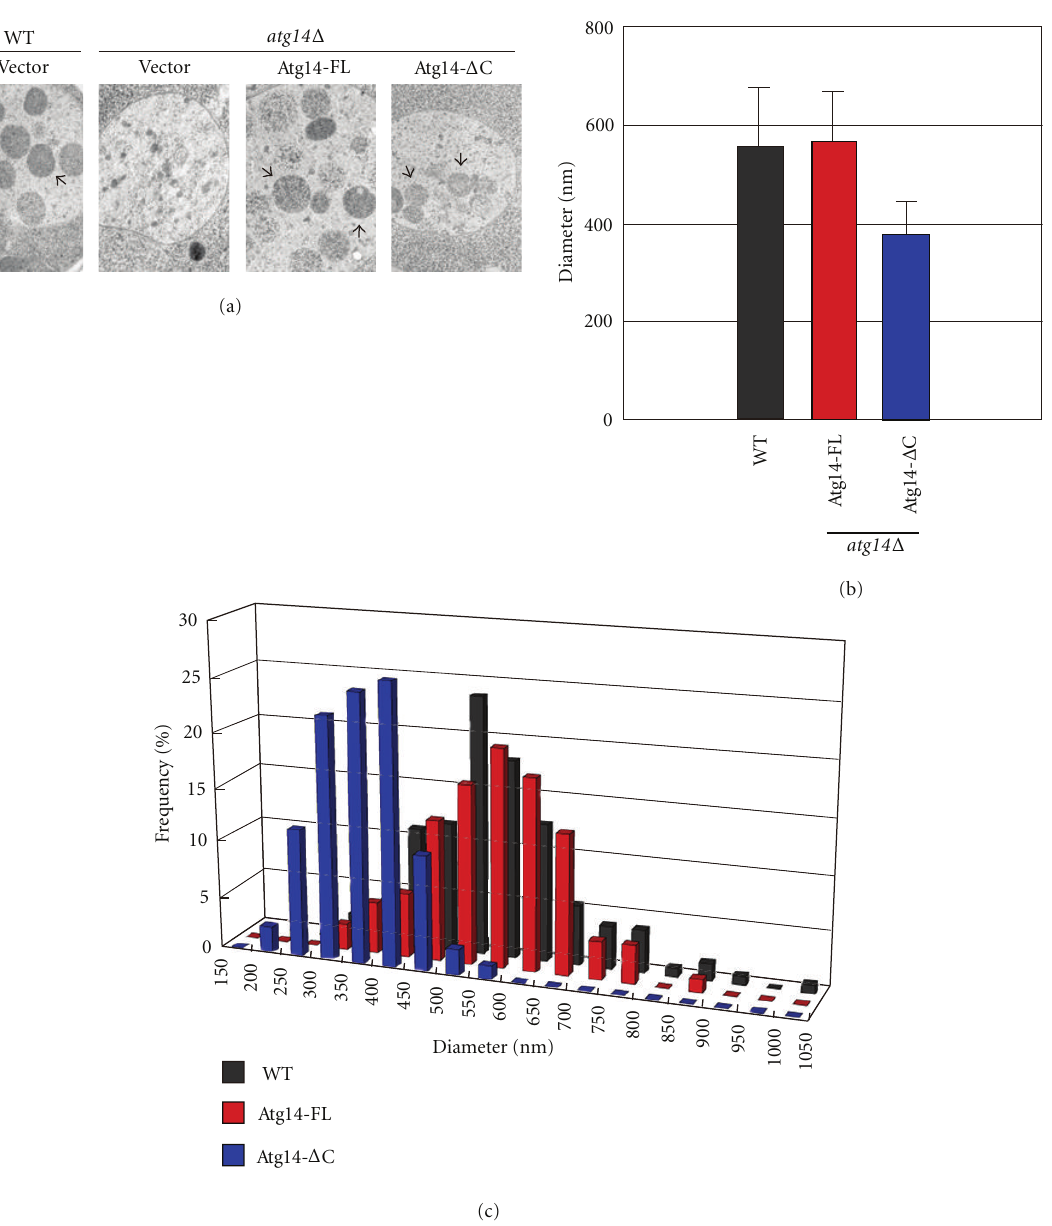
Figure 3: Cells expressing the Atg14- Δ C variant accumulate smaller autophagic bodies. (a) Electron micrographs of autophagic bodies accumulated in BJ2168 cells lacking vacuolar proteases. Cells were cultured for 3.5 h in nitrogen-depleted medium, and the accumulated autophagic bodies (arrow) were observed under an electron microscope. Bar represents 500 nm. (b) Average size of the autophagic body. Autophagic bodies with clear outlines, that is, sliced vertically at the position of the maximum diameter, were chosen, and their diameters were measured. The average autophagic body diameters were 558nm ( n = 128), 567 nm ( n = 86), and 377nm ( n = 86) in WT, Atg14-FL, and Atg14- Δ C cells, respectively. Bars indicate standard deviations. (c) Frequency of autophagic bodies with each